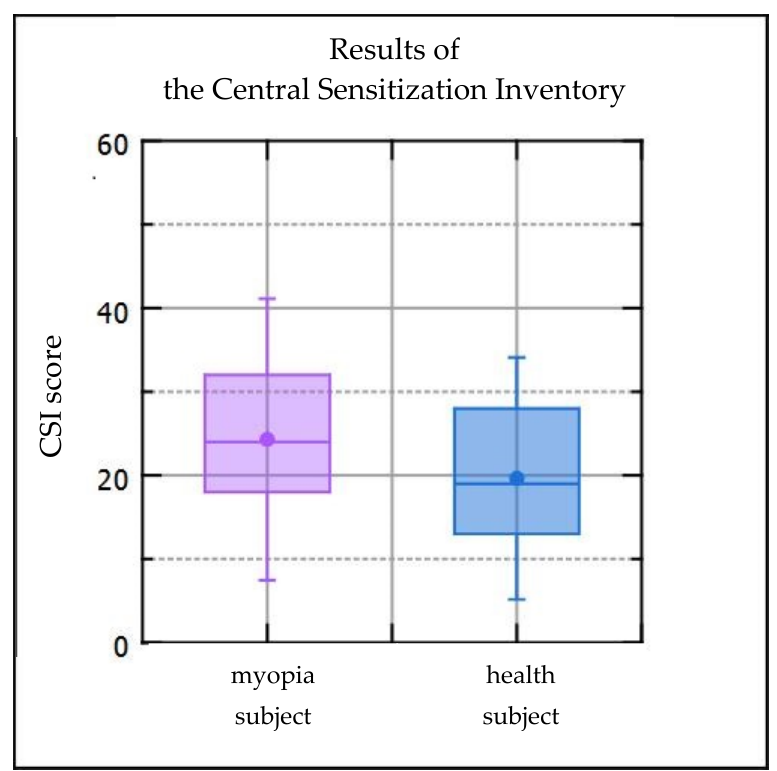
Figure 1. Graphical representation of CSI scores in myopic subjects and healthy subjects. CSI—the central sensitization inventory.